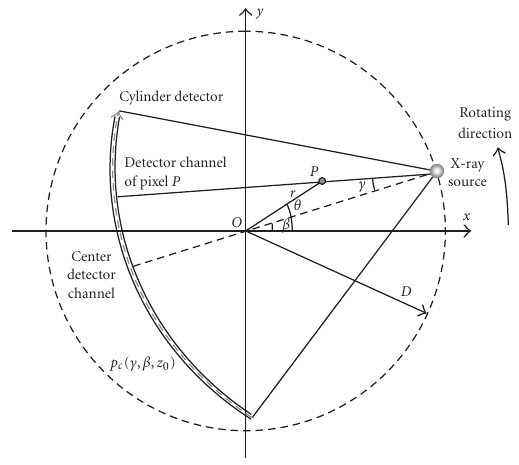
Figure 3: Fan-beam geometry on the z = z 0